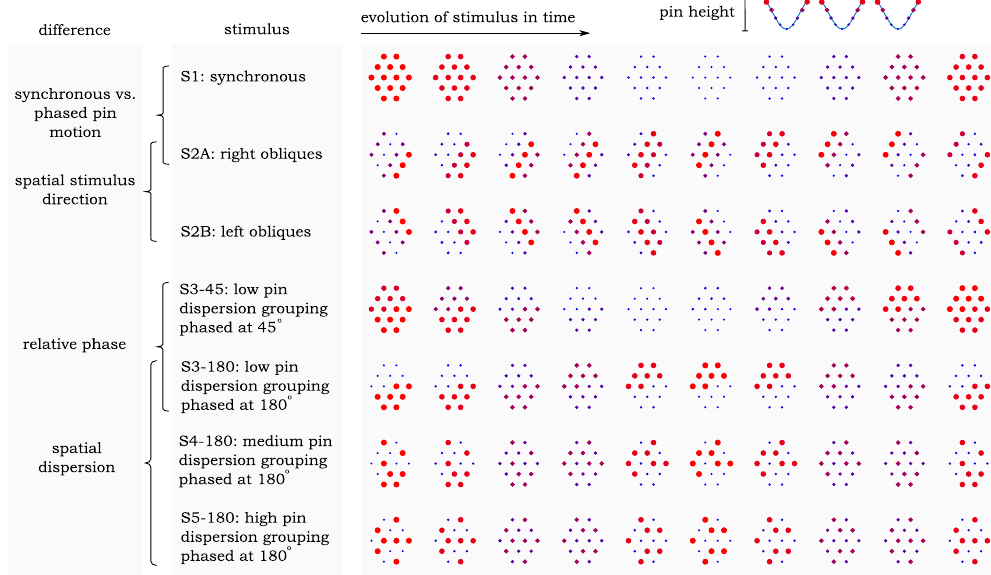
Figure 1. An illustration of single cycles of stimulus evolution as a function of time across several stimulus categories used in the experiments. S1, S2A, and S2B are stimuli used in Experiment 1. S3-x, S4-x, and S5-x stimuli, where x represents relative phase of two pin groupings, are used in Experiments 2 and 3. Note that S1 and S3-x, S4-x, and S5-x are the same stimulus when x = 0. Further note that the spatial wavelength of S2A and S2B stimuli was set to 8